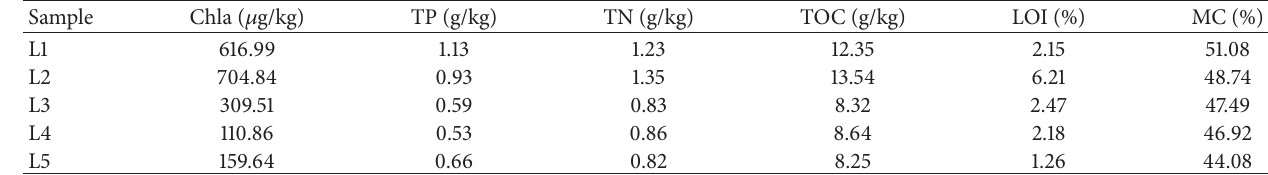
Table 1: Some physicochemical characteristics of the five sediment layers.